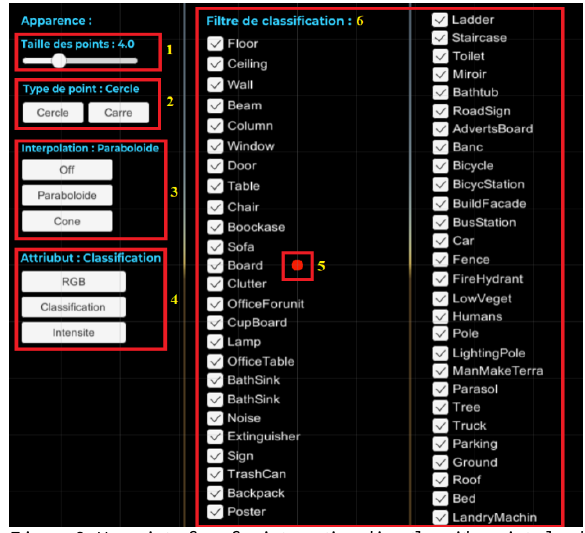
Figure 8. User interface for interacting directly with point cloud. Then, we integrated the Oculus Rift in the Unity project to allow rendering on the headset (the version of the Oculus application used is Oculus 1.39.0.272909) .